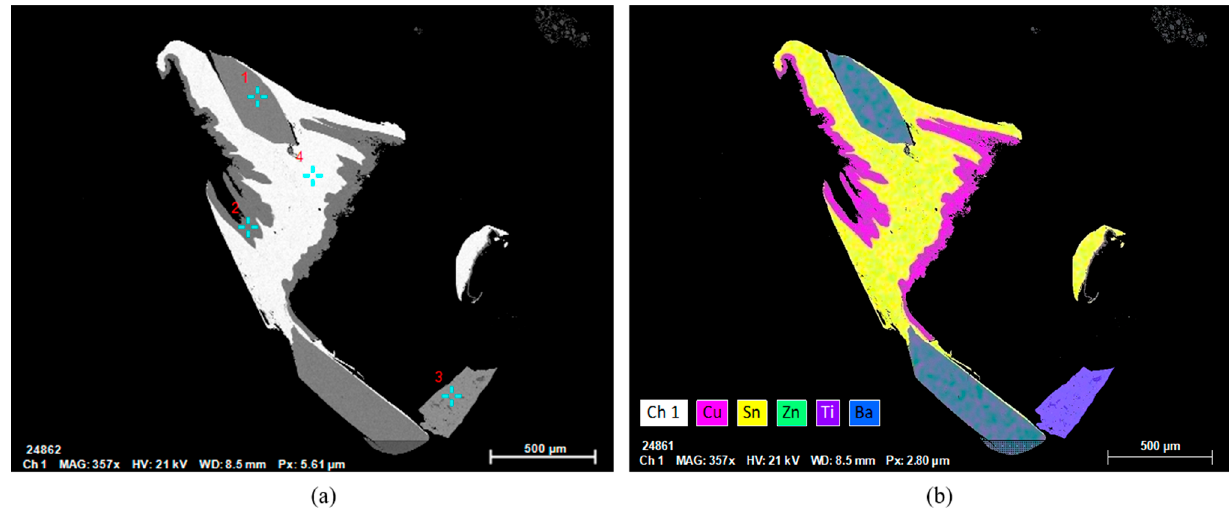
Figure 11. Micrograph (BSE-SEM) of a feed PCB, ( a ) BSE-SEM image; ( b ) EDS-SEM image.